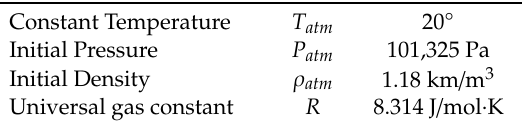
Table 1. Initial conditions of the air phase.